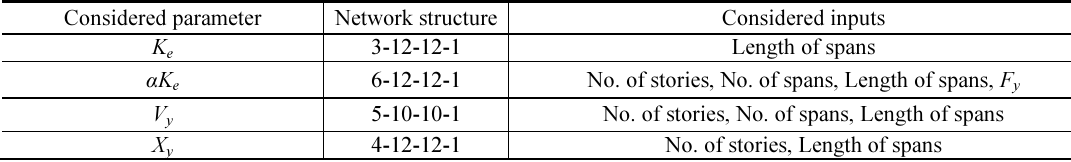
Table 7. Superior trained networks, influential input and corresponding output Considered parameter Network structure Considered inputs